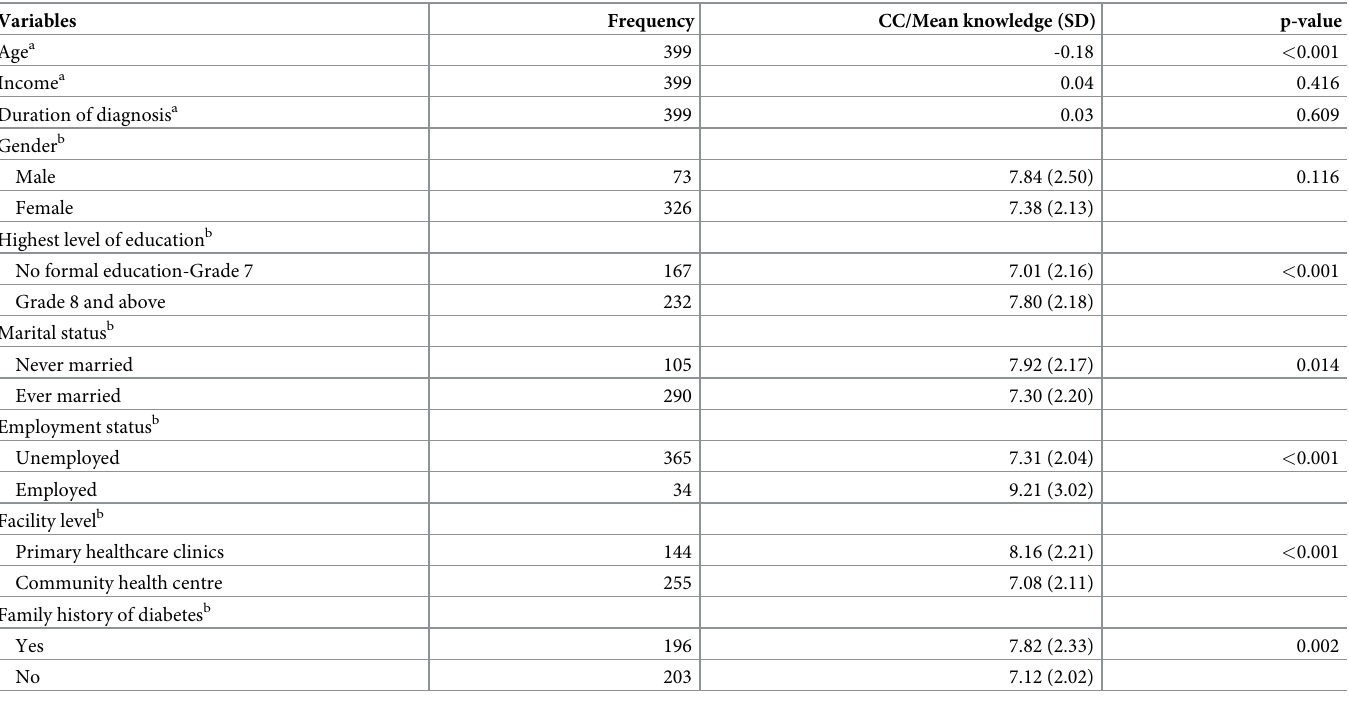
Table 3. Bivariate analysis showing association between patient characteristics and diabetes knowledge.